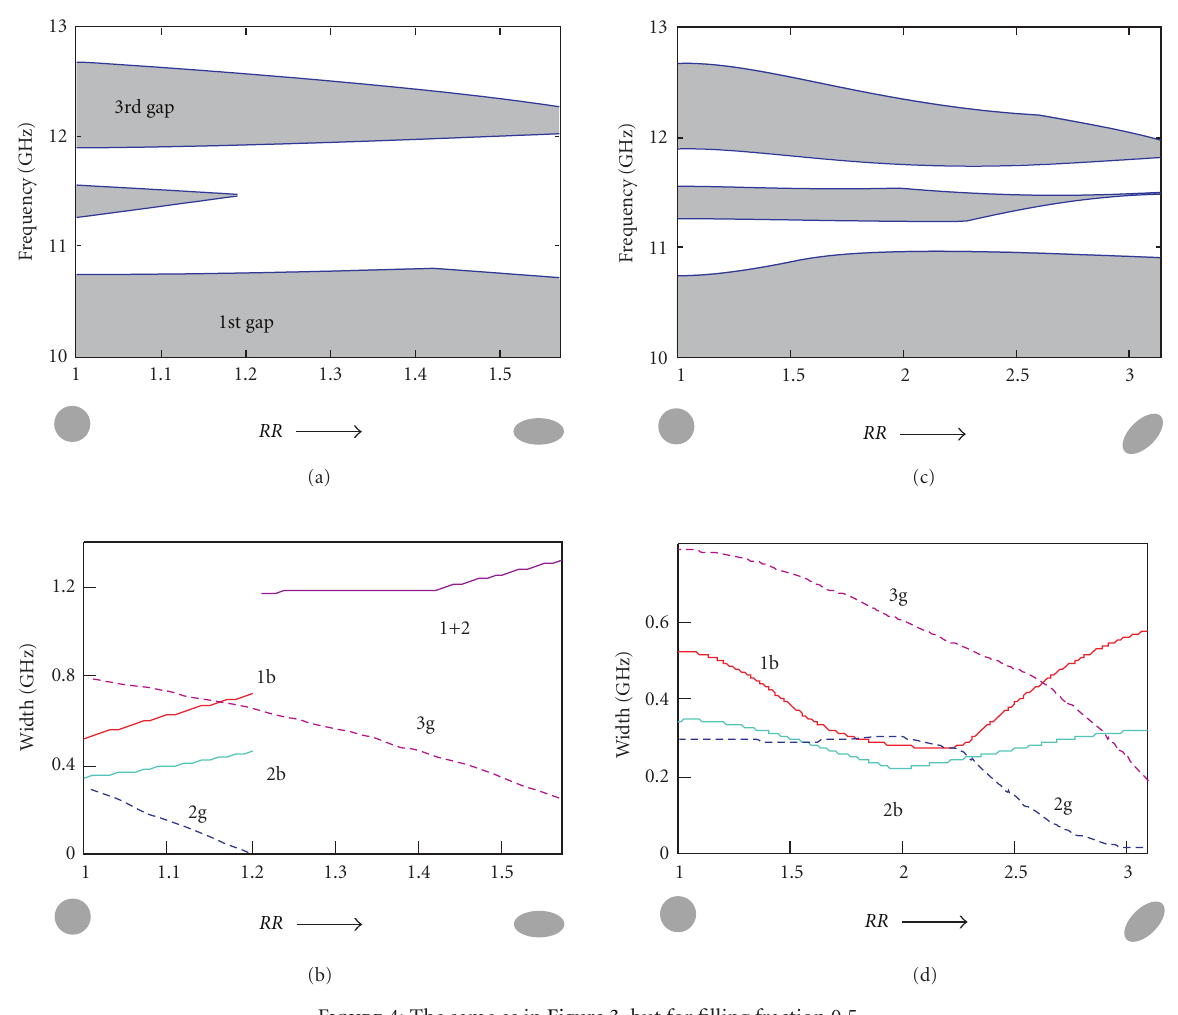
Figure 4: The same as in Figure 3, but for filling fraction